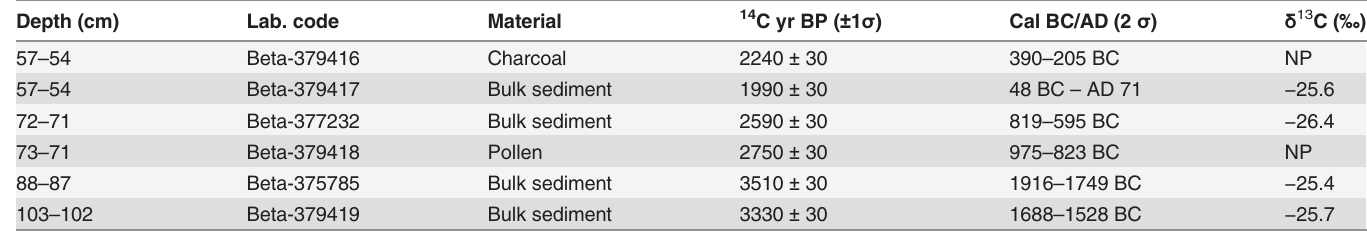
Table 2. Radiocarbon dates from the profile. Depth (cm)